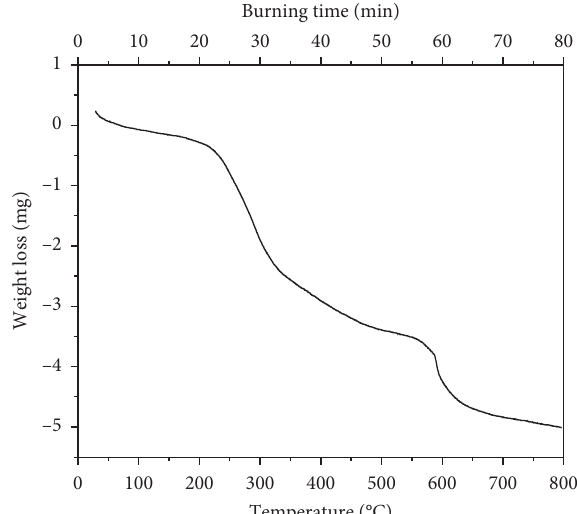
Figure 1: Decomposition profile of catalyst between 29 and 800 ° .